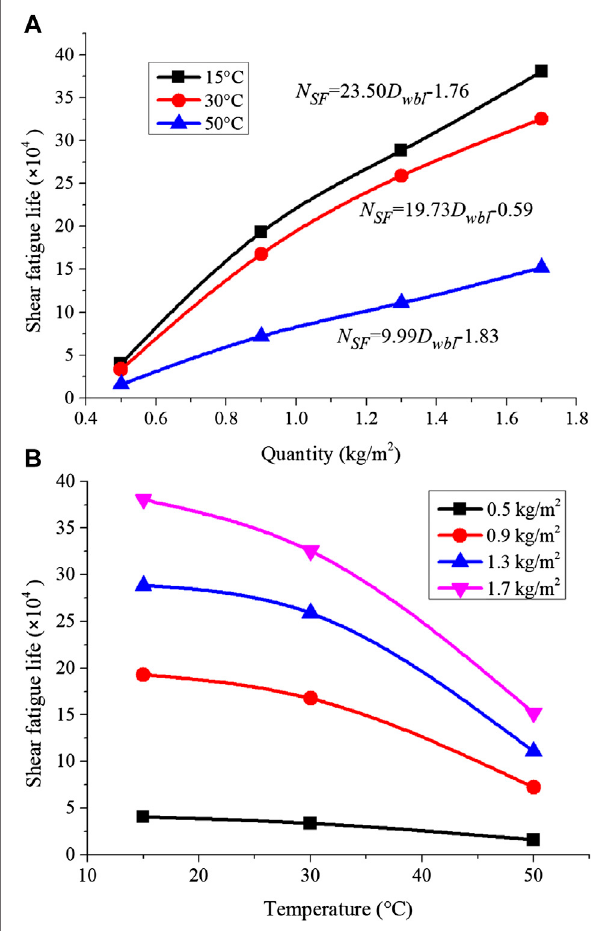
FIGURE 8 | Change trends of shear fatigue life with coating quantity of ER waterproof adhesive and temperature.